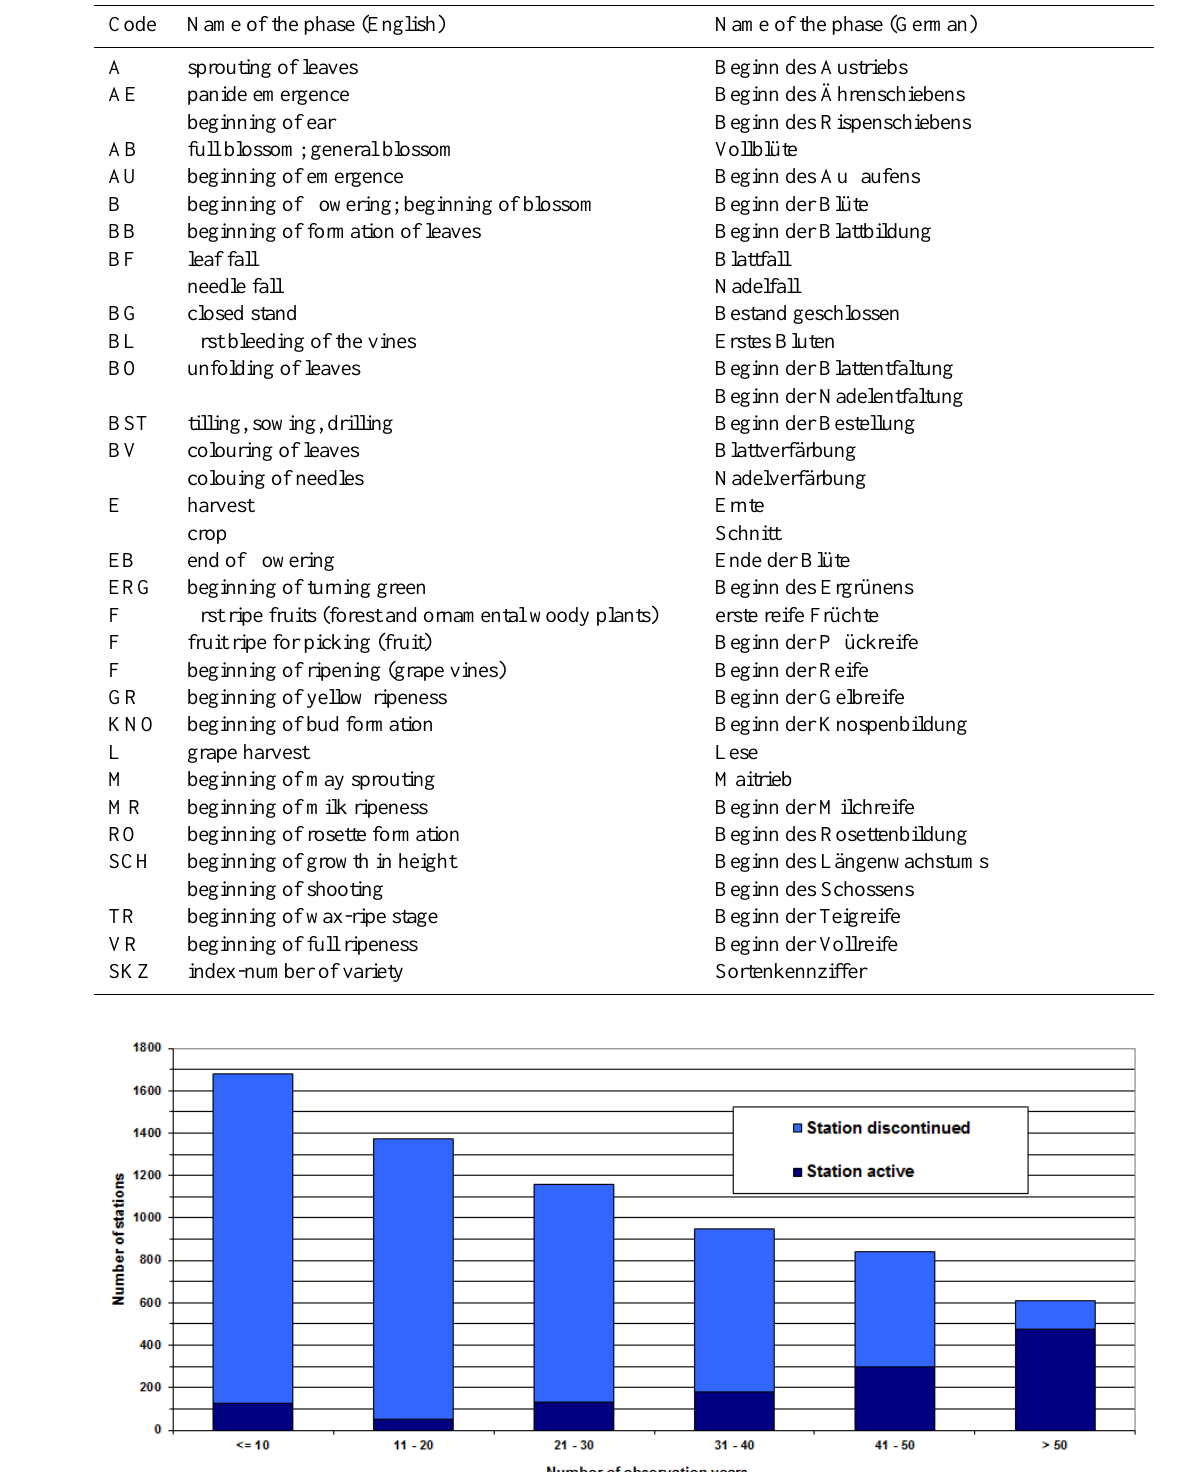
Table 2. Observed phases and their abbreviations.